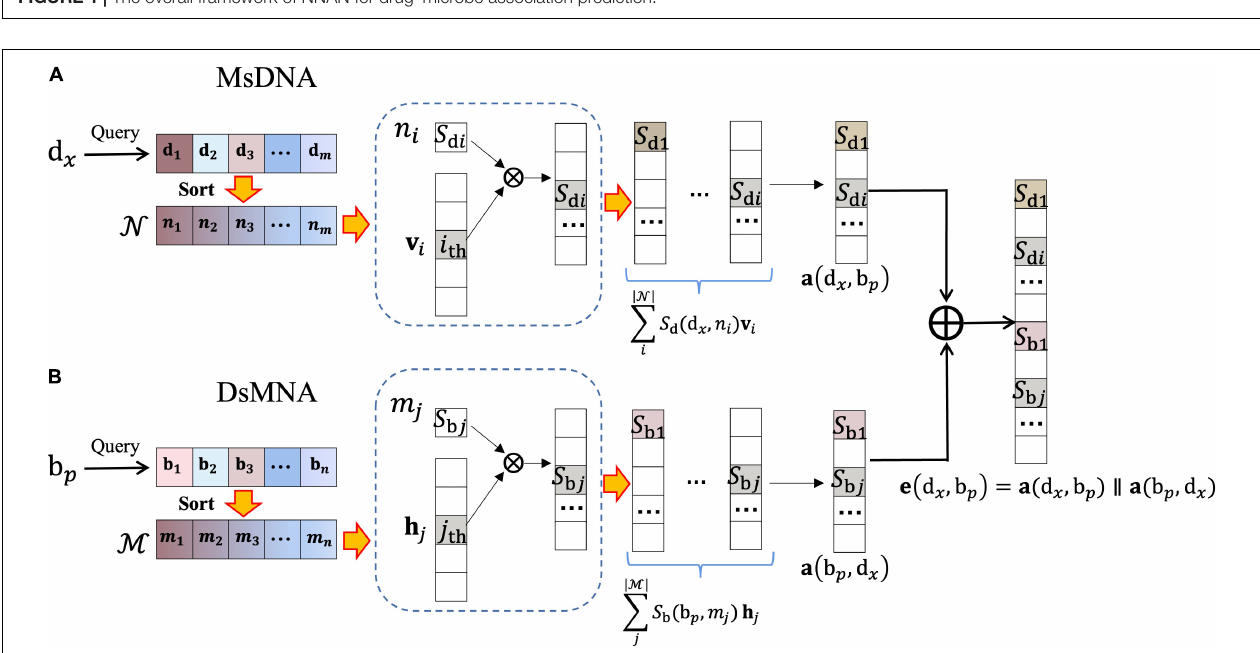
FIGURE 1 | The overall framework of NNAN for drug–microbe association prediction.